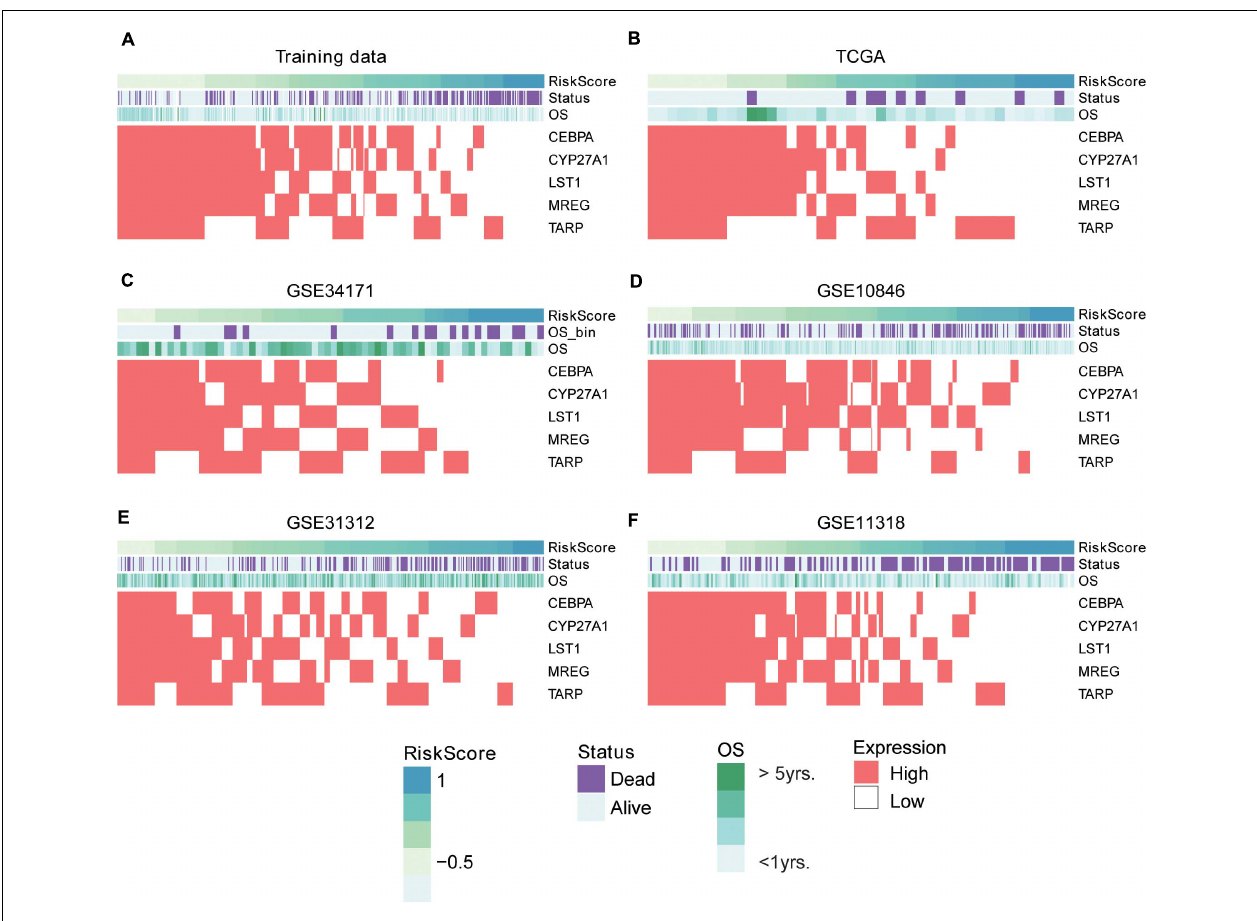
FIGURE 3 | The expression patterns of five prognostic gene signatures in the training and five validation sets. The expression patterns of the five prognostic genes in training (A) and validation (B–F) sets. The risk scores were estimated by the linear predictors of the Cox model. The samples were ordered by the risk